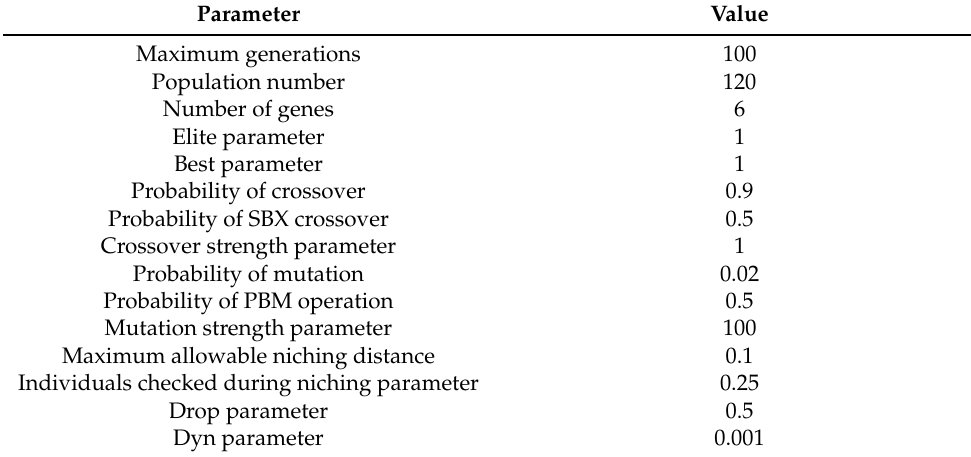
Table 18. Genetic algorithm specifications.